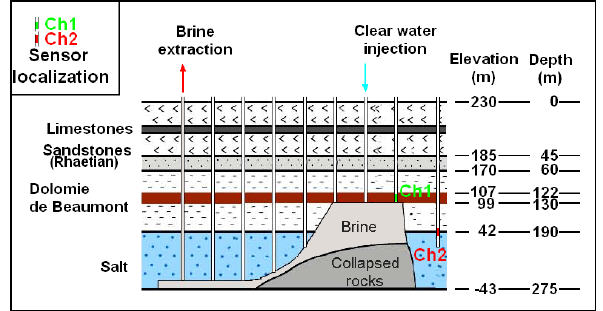
Figure 1. Geological context and state of the cavity prior to collapse. 2 Fig. 1. Geological context and state of the cavity prior to 3